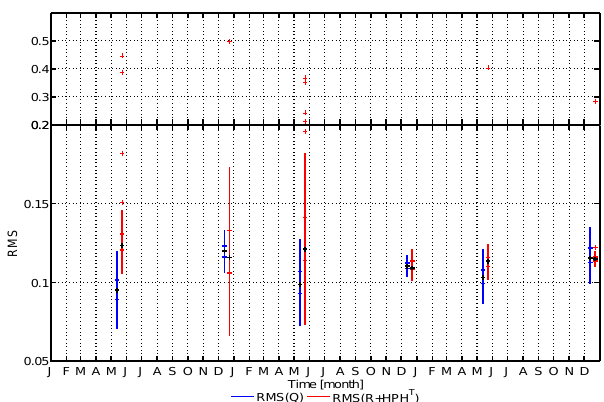
trix (RMS( Q )) in blue and the RMS of the model plus observation error-covariance matrix (RMS( R + HP e H T ) ) in red during May and December in IC simulation. Thin crosses denote the outliers, while the end (beginning) of the whisker corresponds to the 3rd (1st) quartile plus (minus) 1.5 times the interquartile range. Note that the vertical axis is non linear. All RMS estimates are taken only over cells where the observations have an ice concentration larger than